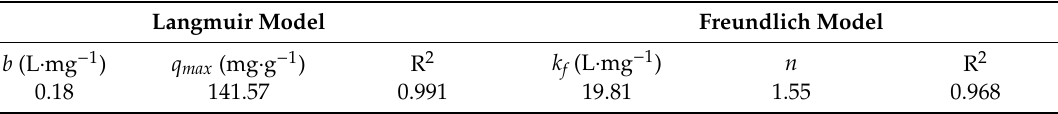
Table 1. Langmuir and Freundlich constants for the adsorption of Hg 2 + ions via HA / Fe 3 O 4 / OS. Langmuir